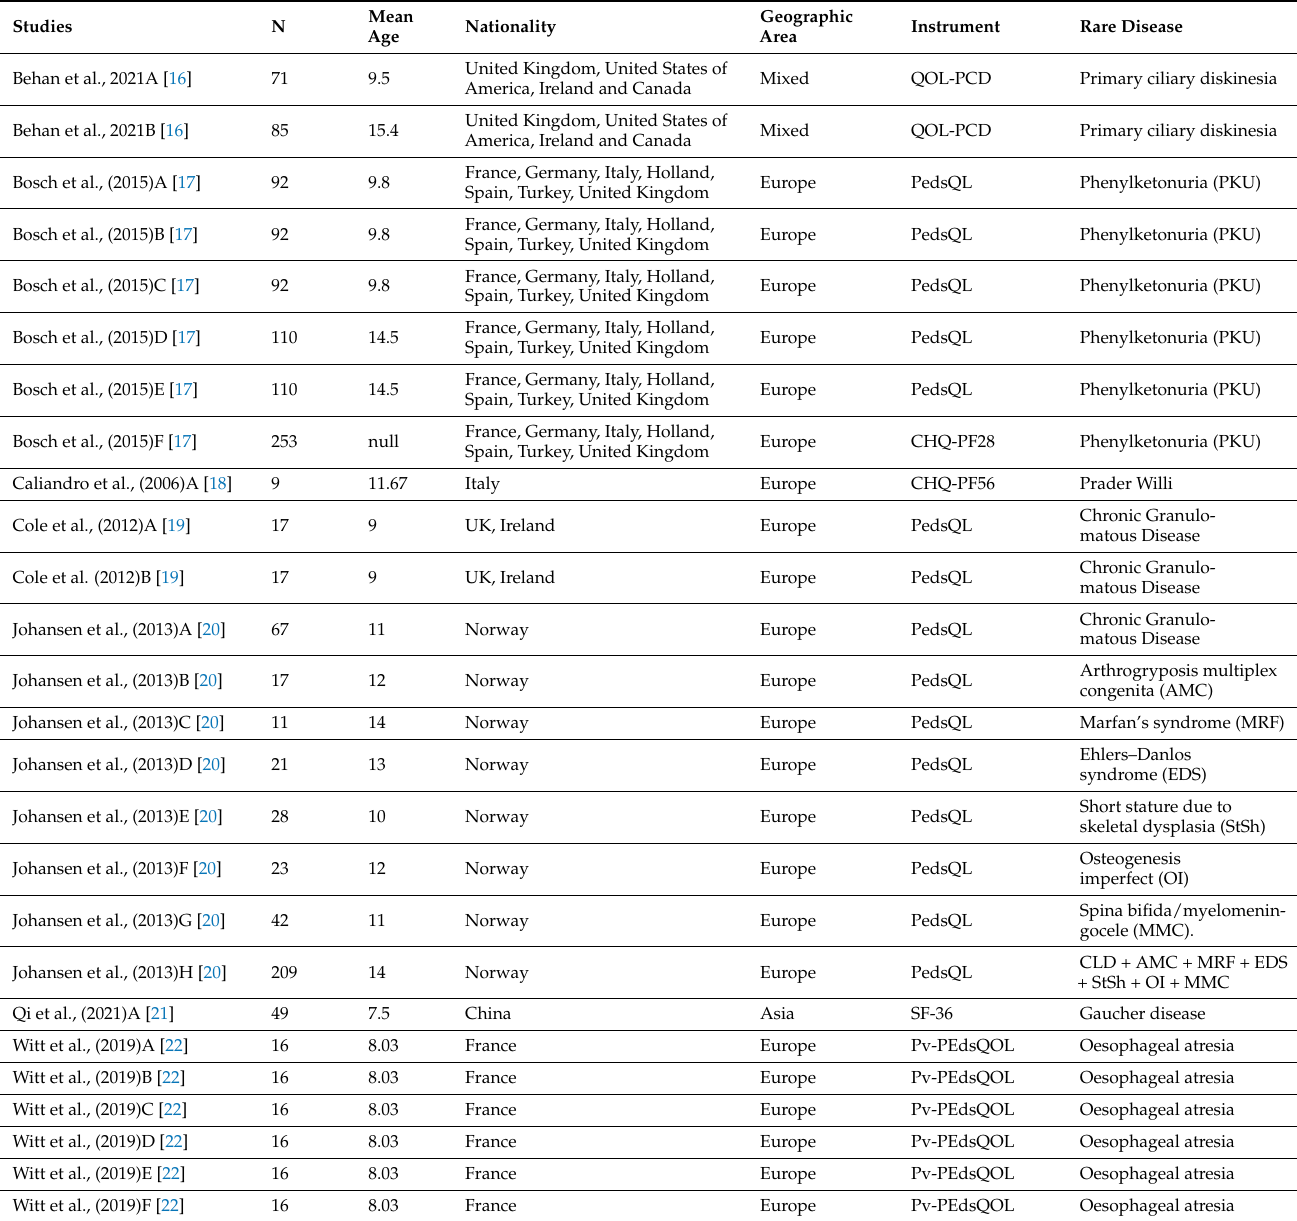
Table 1. Sociodemographic results of the sample in the social